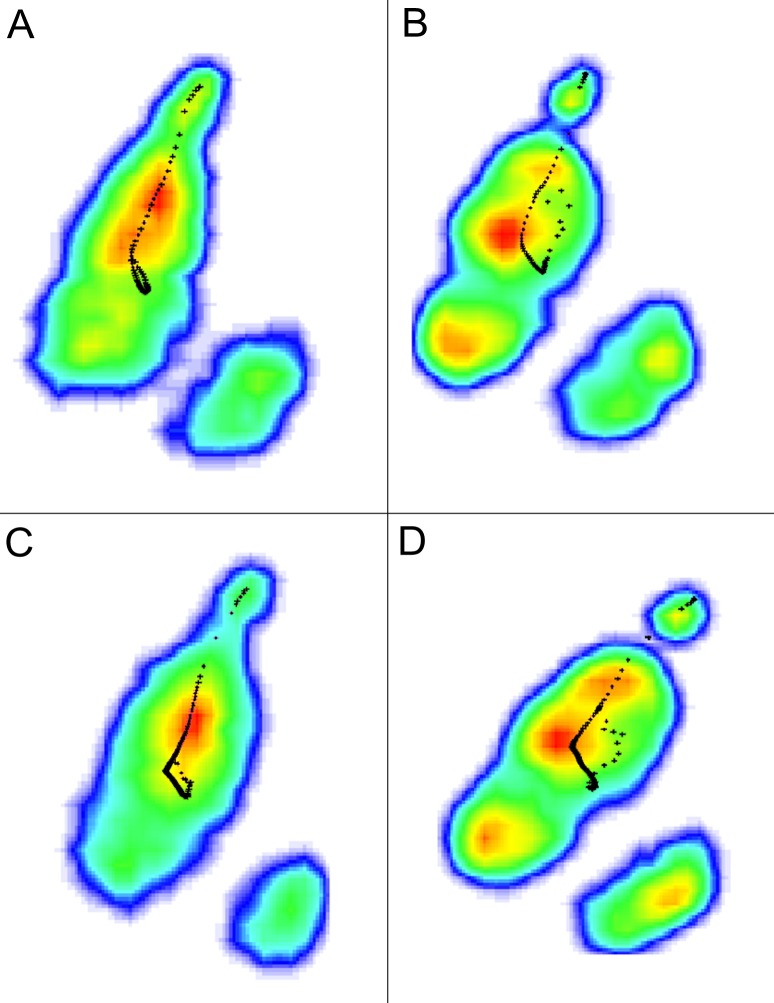
Typical COP path (shown as black dots) of the ostrich right foot.(A) Running on loose sand, (B) running on solid ground, (C) walking on loose sand, (D) walking on solid ground. Red, yellow, green and blue indicate the plantar pressure decreased gradually.